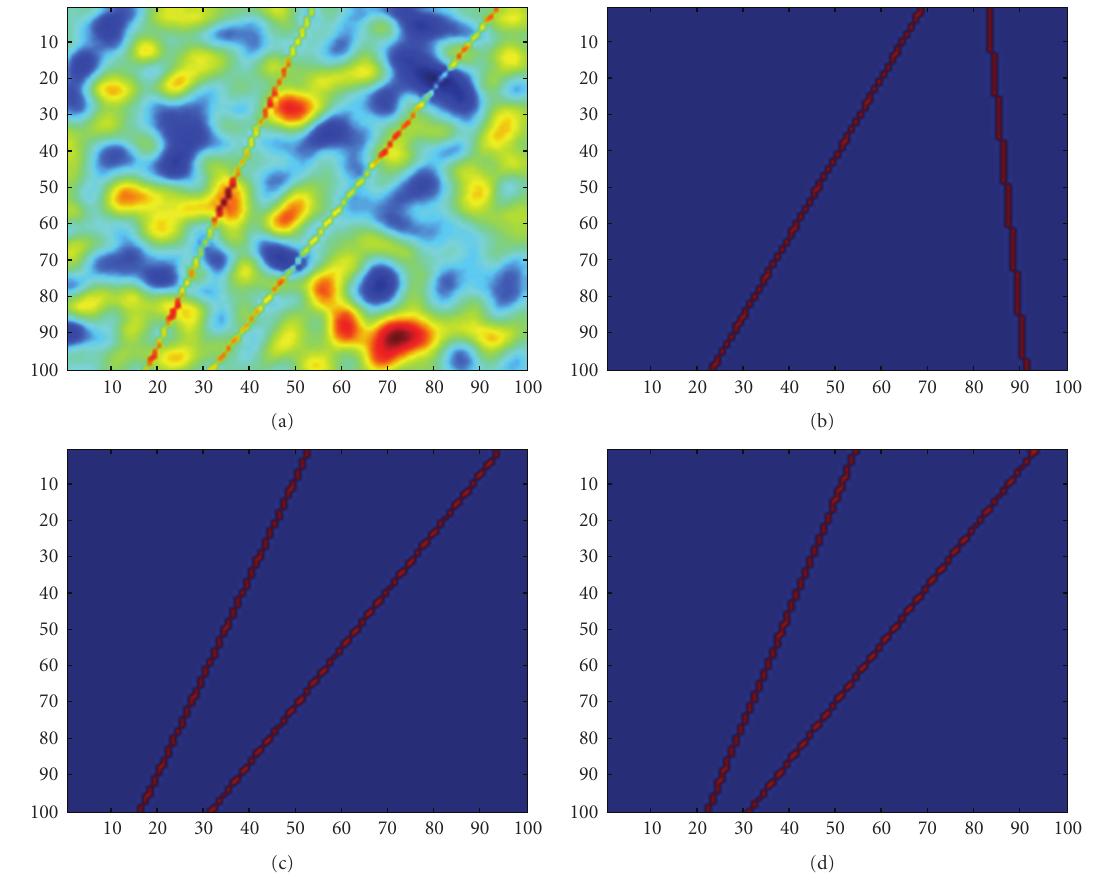
Figure 2: Initial image and estimated results for two lines with 32 and 20 degrees. (a) Initial scaled image. (b) Result without cumulant. (c) MUSIC-like algorithm. (d) TLS-ESPRIT